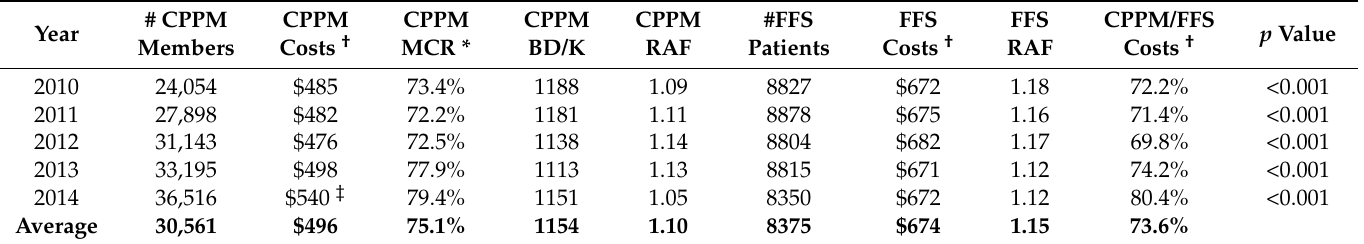
Table 3. Filtered CPPM membership and costs compared to Matched Fee-For-Service Medicare